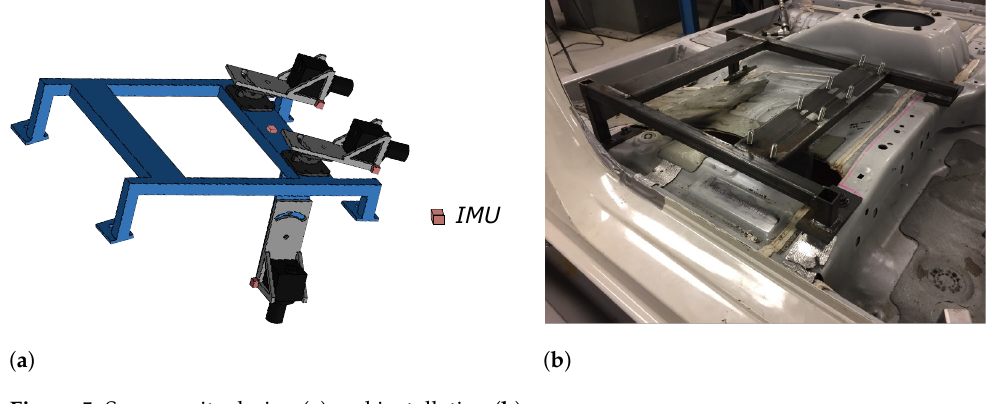
Figure 5. Sensor suite design ( a ) and installation ( b